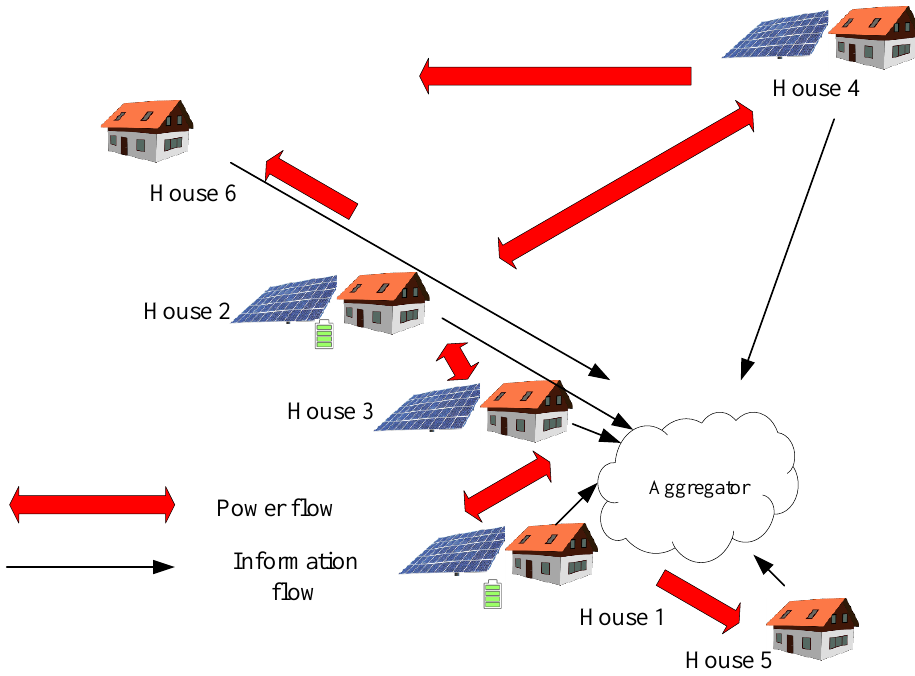
Figure 2. Illustration of the considered P2P trading network structure in the case